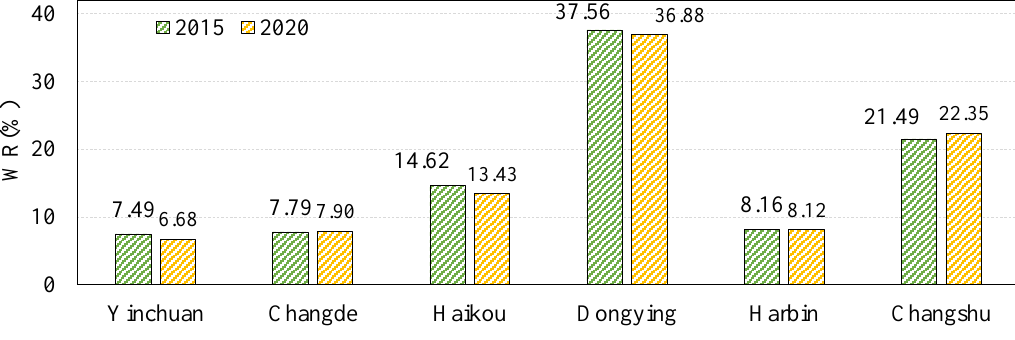
Figure 9. Wetland rate (WR) for 6 cities in 2015 and 2020.